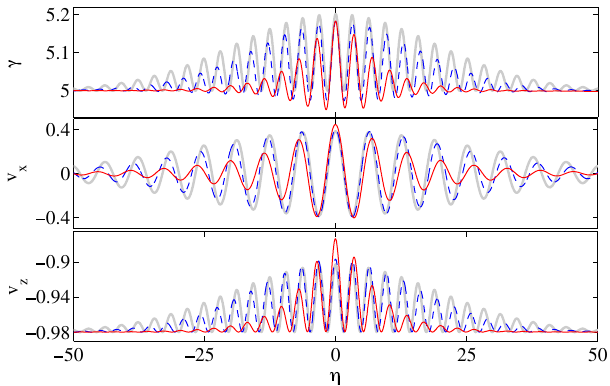
FIG. 3. Plots showing the γ factors and velocity components of the electron in a laser pulse with different focusing. The laser pulse has a Gaussian time envelope and was 27 fs in duration with a peak a 0 ¼ 2 . Gray (thick) lines: θ 0 ¼ 0 . Blue (dashed) lines: θ 0 . 35 . Red (solid) lines: θ 0 . 7 0 ¼ 0 ¼